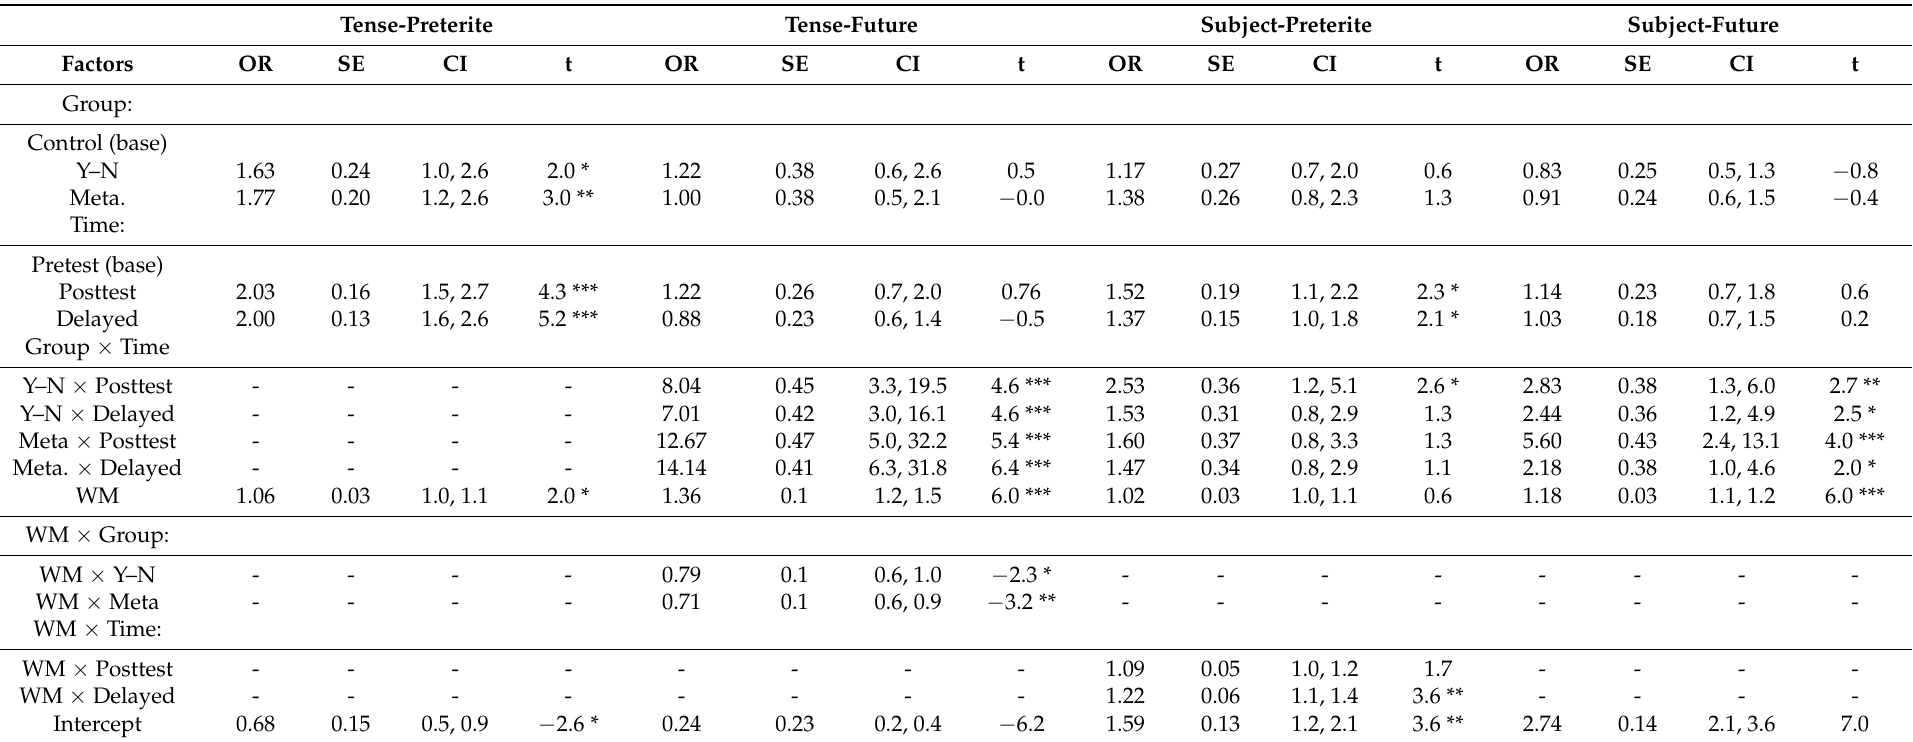
Table 5. Fixed Coefficients from Logit Mixed-Effects Models—Accuracy on the Interpretation Assessment.